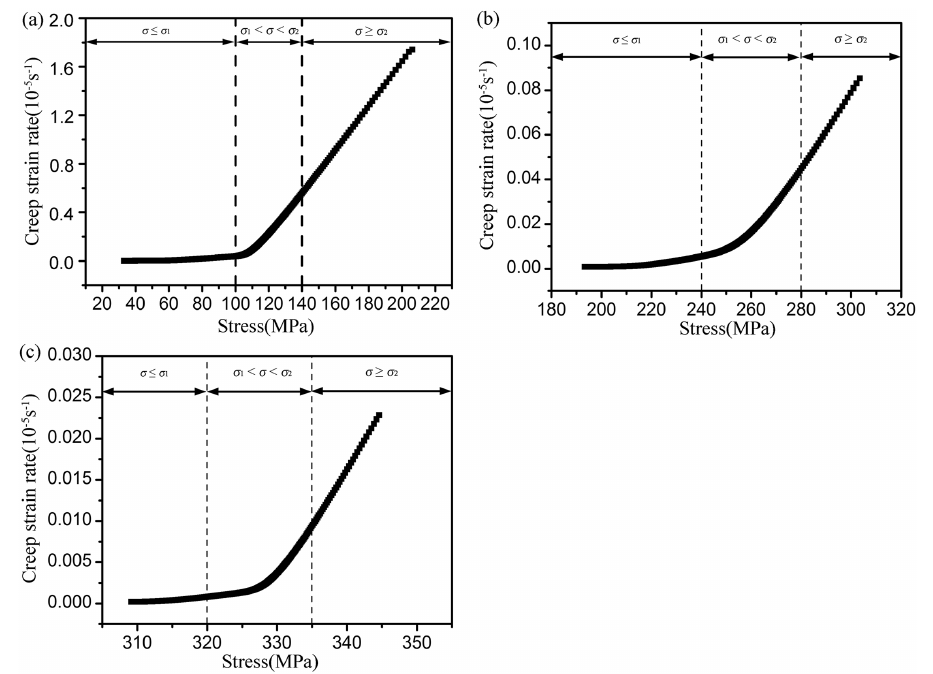
Figure 5: Creep strain rate – stress curves at different tem- peratures: (a) 620°C; (b) 500°C; (c)